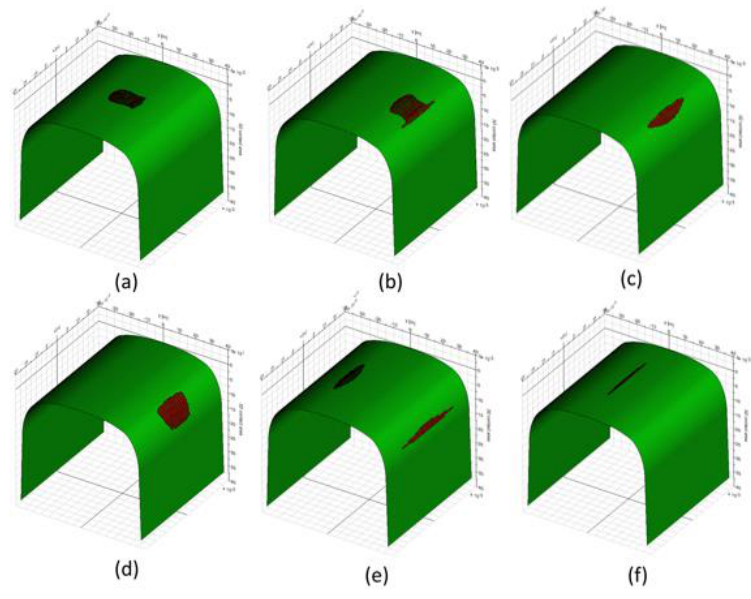
Figure 7. Wheel – rail contact spot variation diagram. Figure 7. Wheel–rail contact spot variation